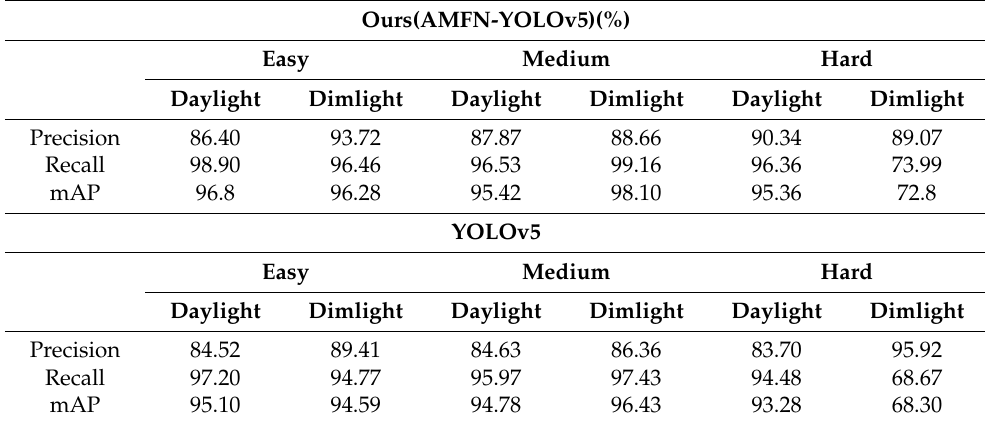
Table 3. Comparison YOLOV5 with AMFN-YOLOv5.